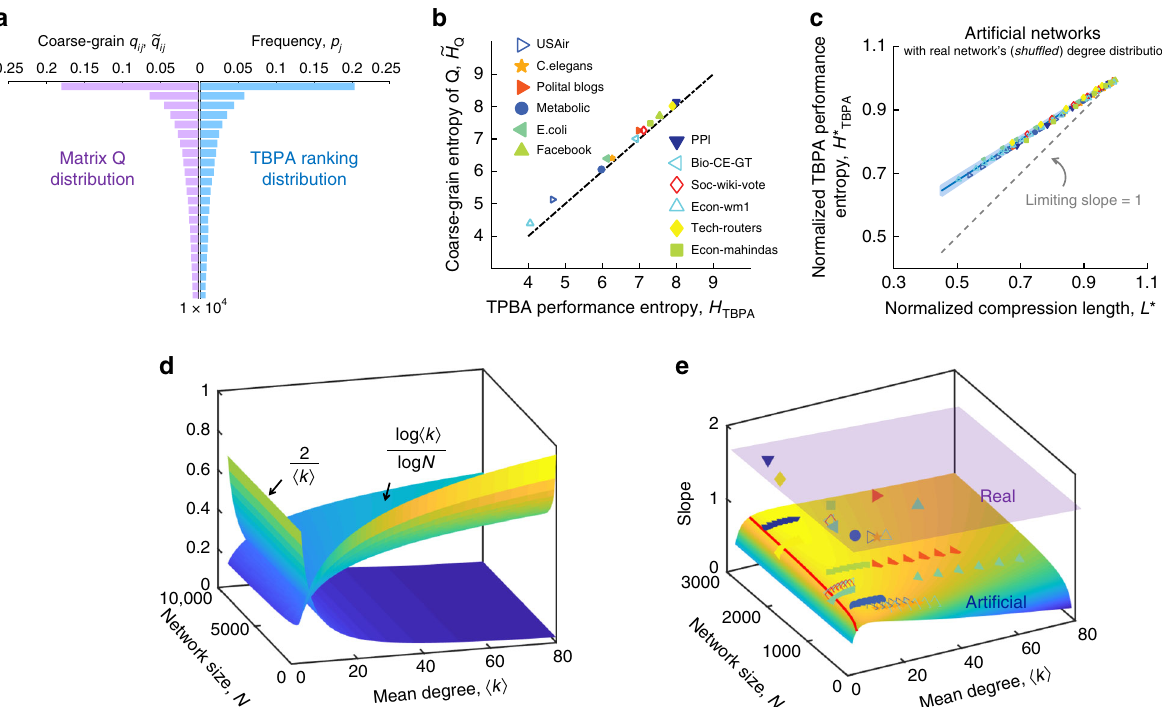
Fig. 3 Theoretical relationship between the shortest compression length and network prediction limit. Networks are generated from a static random matrix Q with elements generated from the degree distribution of empirical networks. a Comparison between the ranking distribution from TBPA and that from random matrix Q based on Metabolic network 29 . The left half represents the ranking distribution of coarse-grained probabilities ~ q ij , each of which is the average value of every N values of q ij ranked in a descending order. The right half illustrates the TBPA ranking distribution of existing links for this arti fi cially generated network. The probability p j is an average value from 100 simulations. b Values of coarse-grained entropy ~ H from the probability Q distribution ~ q ij vs. TBPA performance entropy H TBPA for all of the arti fi cial networks generated from the empirical ones. Each dot corresponds to the value of ; ~ H ( H ) of an arti fi cial network, showing a good match between the two values. c Theoretical linear relationship between L * and H (cid:2) calculated based Q TBPA TBPA on the empirical networks' degree distributions. Points of the same shape and color correspond to an empirical network (bottom-left) and its different shuf fl ed versions, i.e., having its links shuf fl ed different number of times up to all of original links. Each point represents the value pair of ð L (cid:2) ; H (cid:2) Þ of an TBPA arti fi cial network with the same degree distribution as a corresponding (shuf fl ed) empirical network. L * is calculated from Eq. (1) and H (cid:2) is calculated TBPA from Eq. (6). The blue solid line is the average of 12 studied networks' analytical slopes obtained from Eq. (7) and the shaded region denotes the standard deviation. The gray dash line is the analytical result of Eq. (9) for the limit of 〈 k 〉 → ∞ . d Competition between two terms of the slope in Eq. (8). e The empirical and theoretical value of slope in the linear relationship between L * and H (cid:2) . The purple plane denotes the plane of empirical value at 1.63, and TBPA each colored point on the plane represents a real network. The lower curved surface below represents the theoretical values of the slope given by Eq. (7), and each colored point on the lower surface represents an arti fi cial network constructed with the same degree distribution as original empirical networks, and the subsequent points with the same color are the arti fi cial networks with randomly added links to increase 〈 k 〉 . The red curve ( ln N ¼ h k i ) on the lower surface is an estimated boundary (see Supplementary Note 9) that our theories are not valid far from the left side of